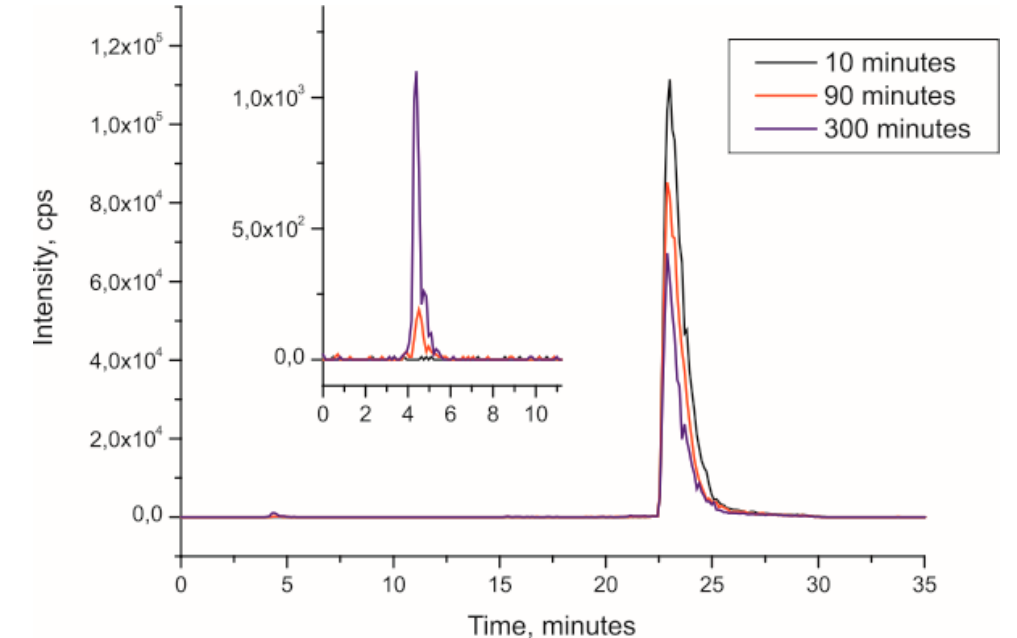
Figure 4. Changes in amount of quercetin (22.8 min) and protocatechuic acid (4.5 min) during incubation of quercetin with saliva.